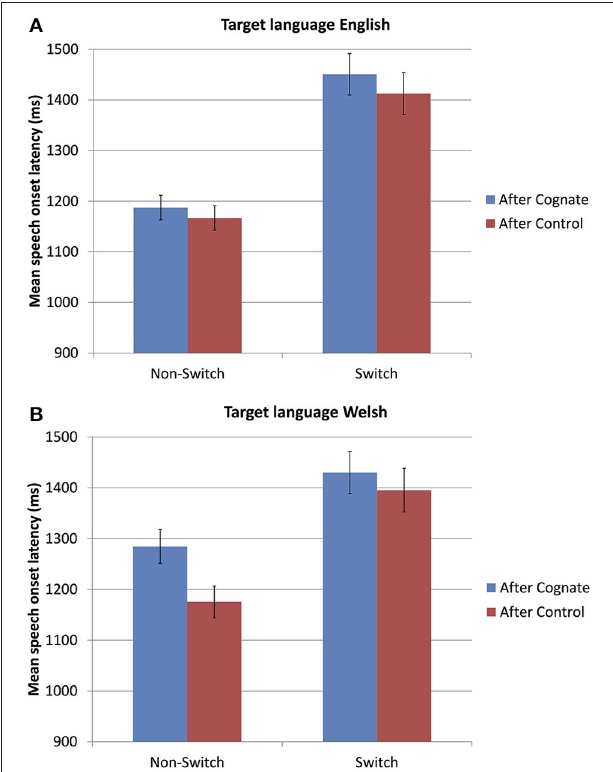
FIGURE 2 | (A,B) Mean naming latencies for non-cognate filler words, in each Target Language ( A , English; B , Welsh), for each Cognate condition (i.e., cognate status in the preceding trial), and Language Switching condition. Error bars represent the standard error of the mean across subjects and are for illustrative purposes